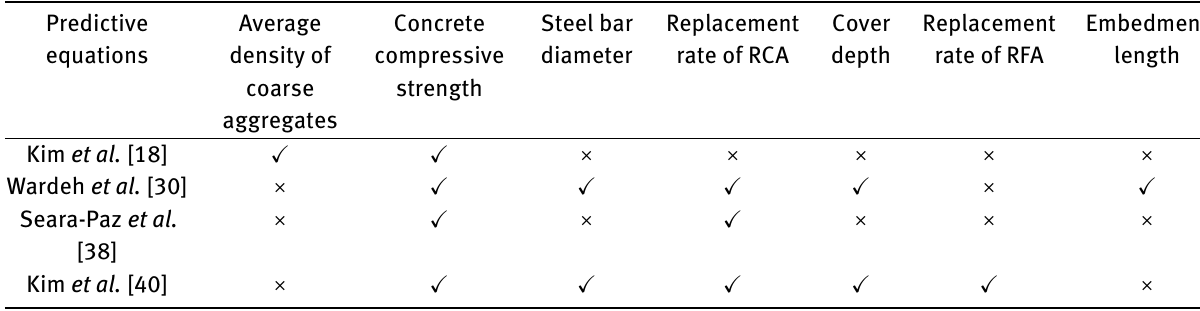
Table 2: Factors for determining bond strength predictive equations Predictive